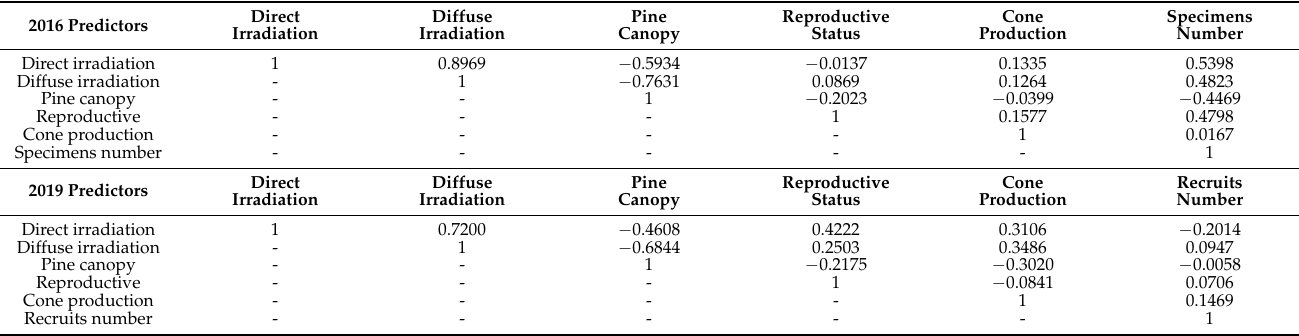
Table 5. Pearson’s correlation indices of the predictors used to study the demographic response before (2016) and after (2019) the experiment.